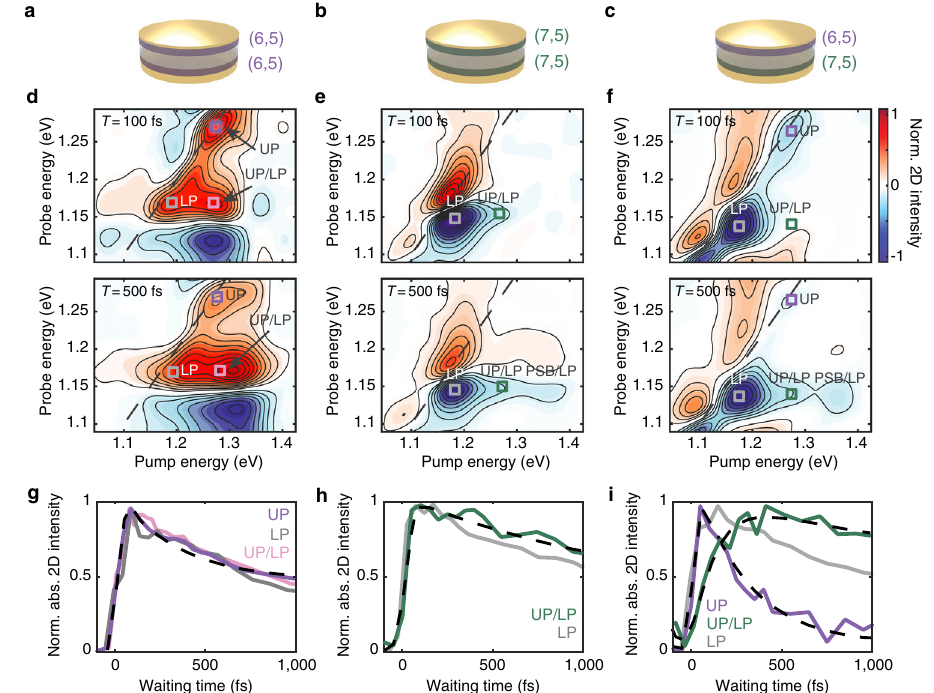
Fig. 2 | Two-dimensional white-light (2DWL) spectra and energy relaxation dynamicsinthemicrocavities. Cartoonillustrationsofthe(6,5)-( a ),(7,5)-( b )and mixed(6,5)/(7,5)microcavities( c ). d – f 2DWLspectraofthemicrocavitiesatwaiting times ( T ) of 100 fs (top) and 500 fs (bottom). The spectra are normalized to the maximum magnitude of the 2D signal in the T =100 fs spectrum for each sample. Ground-state bleach/stimulated emission and excited-state absorption are plotted